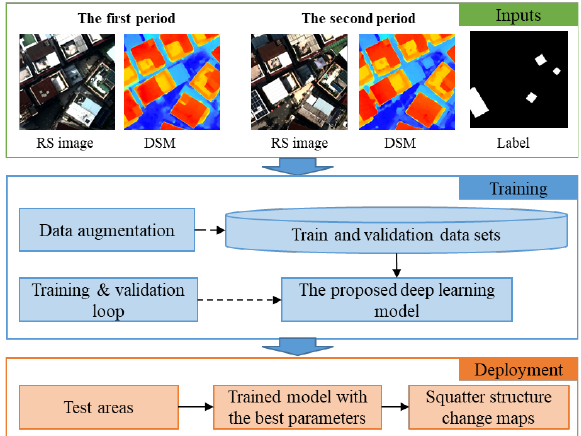
Figure 1 . The schematic workflow of proposed method for squatter structure change detection.